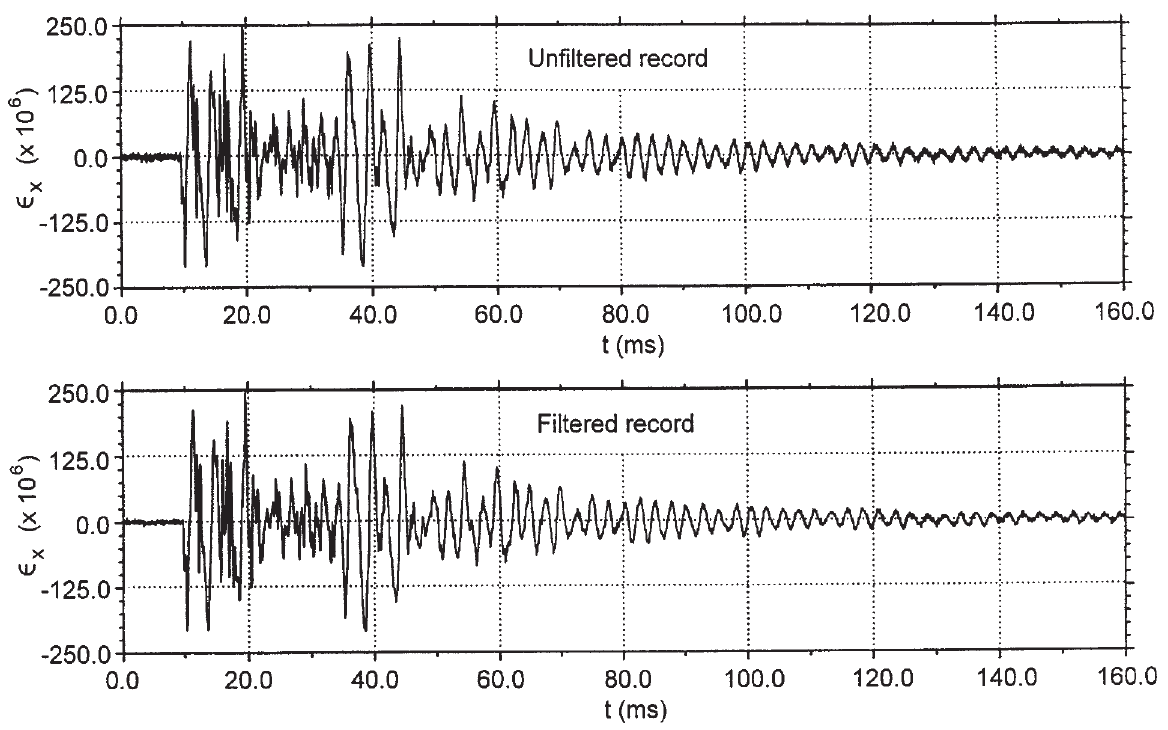
Fig. 9. Effect of filtering on a typical strain record (rosette 3) – circumferential direction.